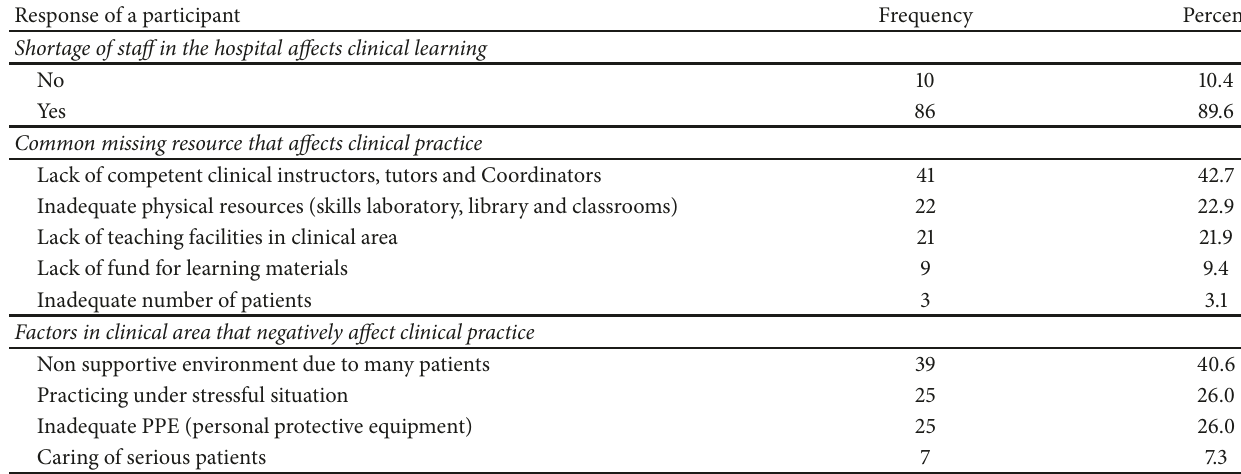
Table 6: Factors affecting performance in clinical practice in hospital